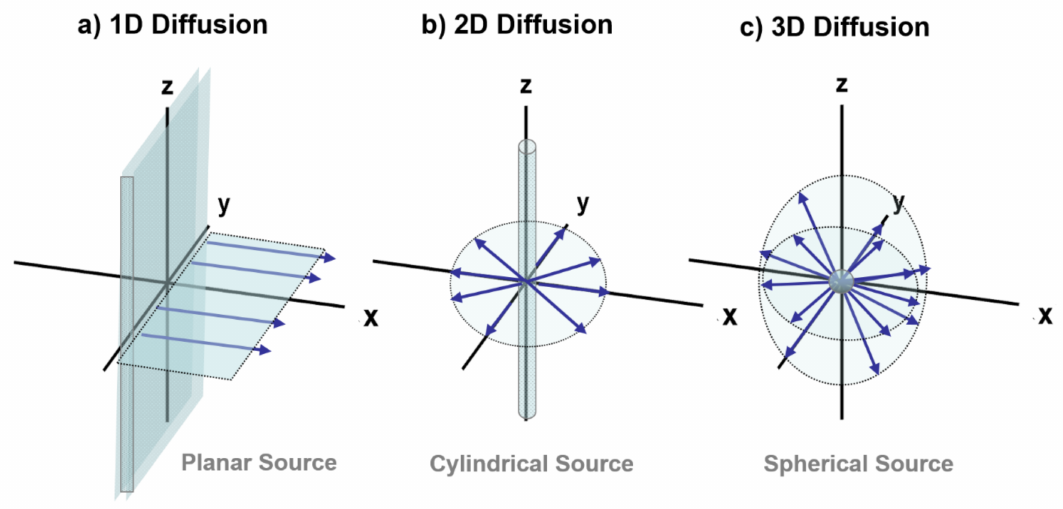
Figure 3. Net direction of molecular diffusion in typical cases of ( a ) 1D, ( b ) 2D and ( c ) 3D geometry, with concentrations deposited at t = 0 as instantaneous finite masses in the blue source domains with darker